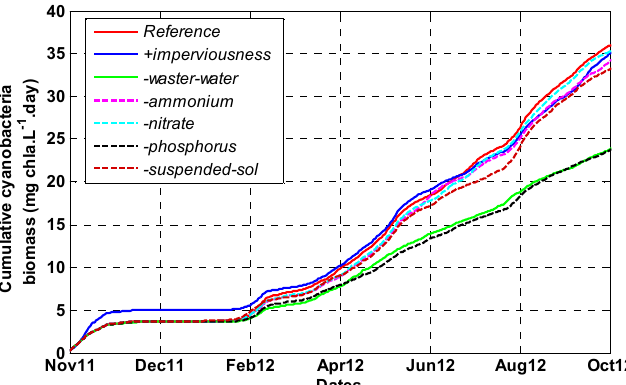
Figure 9. Daily cumulative cyanobacteria biomass (averaged from 0 to 2.5 m depth) in Lake Pampulha for all scenarios.